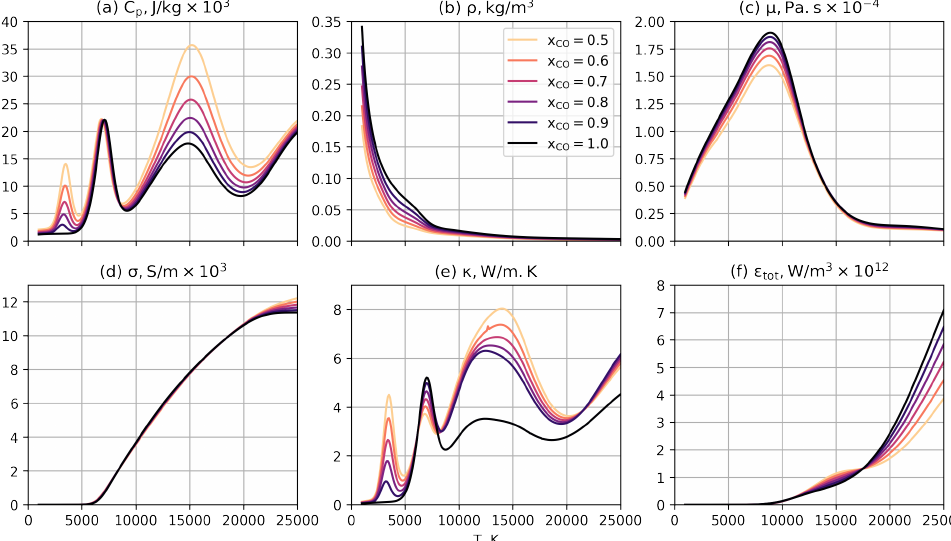
Figure 3. Material properties for syngas plasmas at atmospheric pressure: ( a ) Heat capacity. ( b ) Den- sity. ( c ) Viscosity. ( d ) Electrical conductivity. ( e ) Thermal conductivity. ( f ) Volumetric total radiation emission